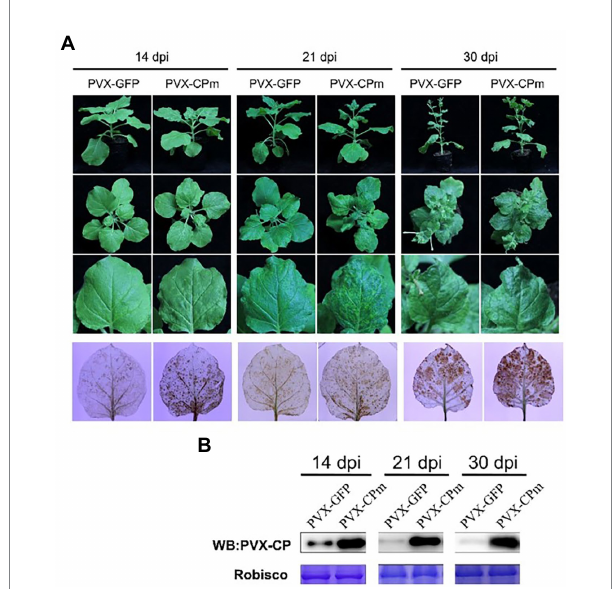
FIGURE 2 Symptoms and H 2 O 2 accumulation exhibited in plants inoculated with potato virus X (PVX) or PVX-CPm. (A) Severe mosaic symptoms induced H 2 O 2 accumulation in leaves of Nicotiana benthamiana plants by PVX-CPm. The 3rd line of infected leaves were stained with 3,3 ′ -diaminobenzidine (DAB) and photographed directly. (B) Western blotting analysis of PVX CP protein in systemic leaves from N. benthamiana plants infected with PVX-GFP or